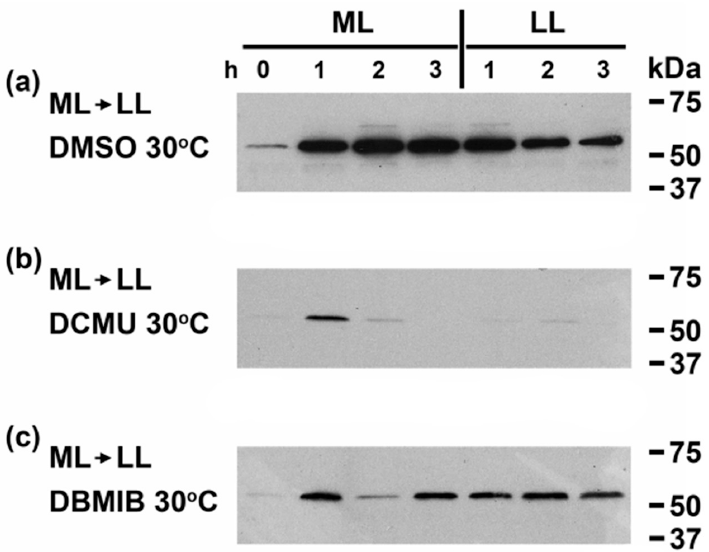
Figure 2. Light quantity and ETC inhibitor effect on CrhR accumulation at 30 ◦ C. Wild type Synechocystis cells were grown to mid-log phase at 30 ◦ C (T = 0) and the combined effect of light quantity and ETC inhibitors on CrhR accumulation was analyzed by Western blotting. ( a – c ) Light quantity. Cells grown at LL (36 µ mol m − 2 s − 1 ) were sampled every hour after transfer to ML (150 µ mol m − 2 s − 1 ) for 3 h and upon return to LL up to 3 h in the presence of DMSO ( a ); DCMU ( b ); DBMIB ( c ). CrhR protein abundance was determined by Western blotting, as described in Figure